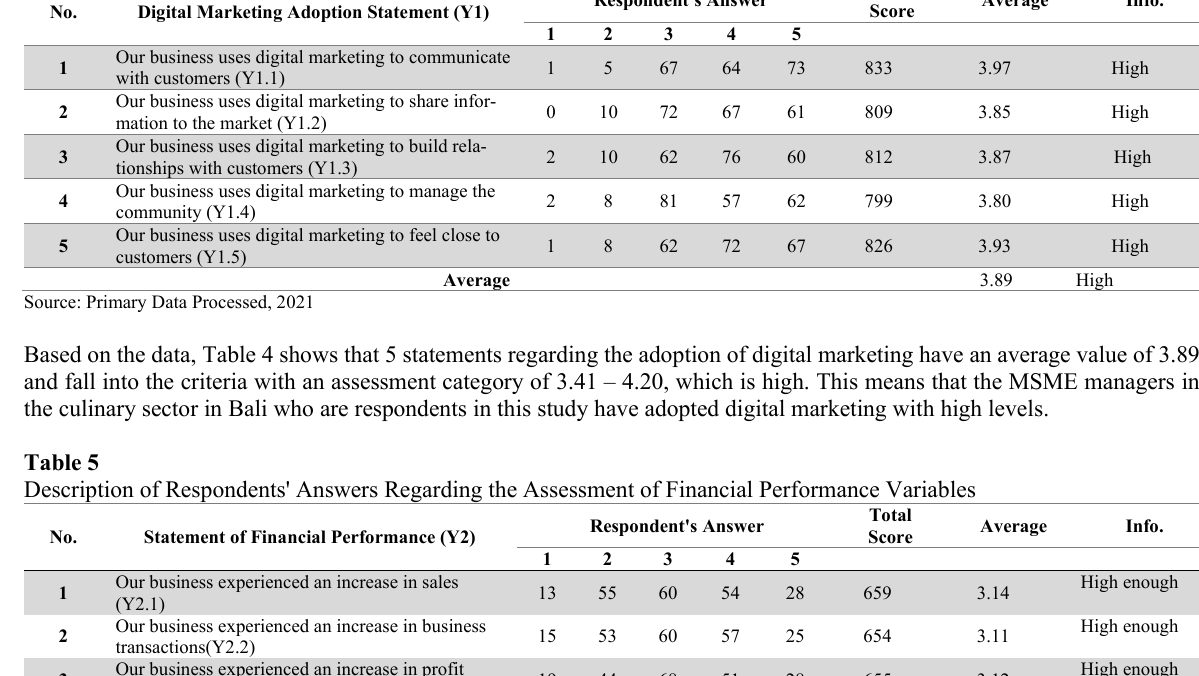
Description of Respondents' Answers Regarding Assessment of Digital Marketing Adoption Variables No.